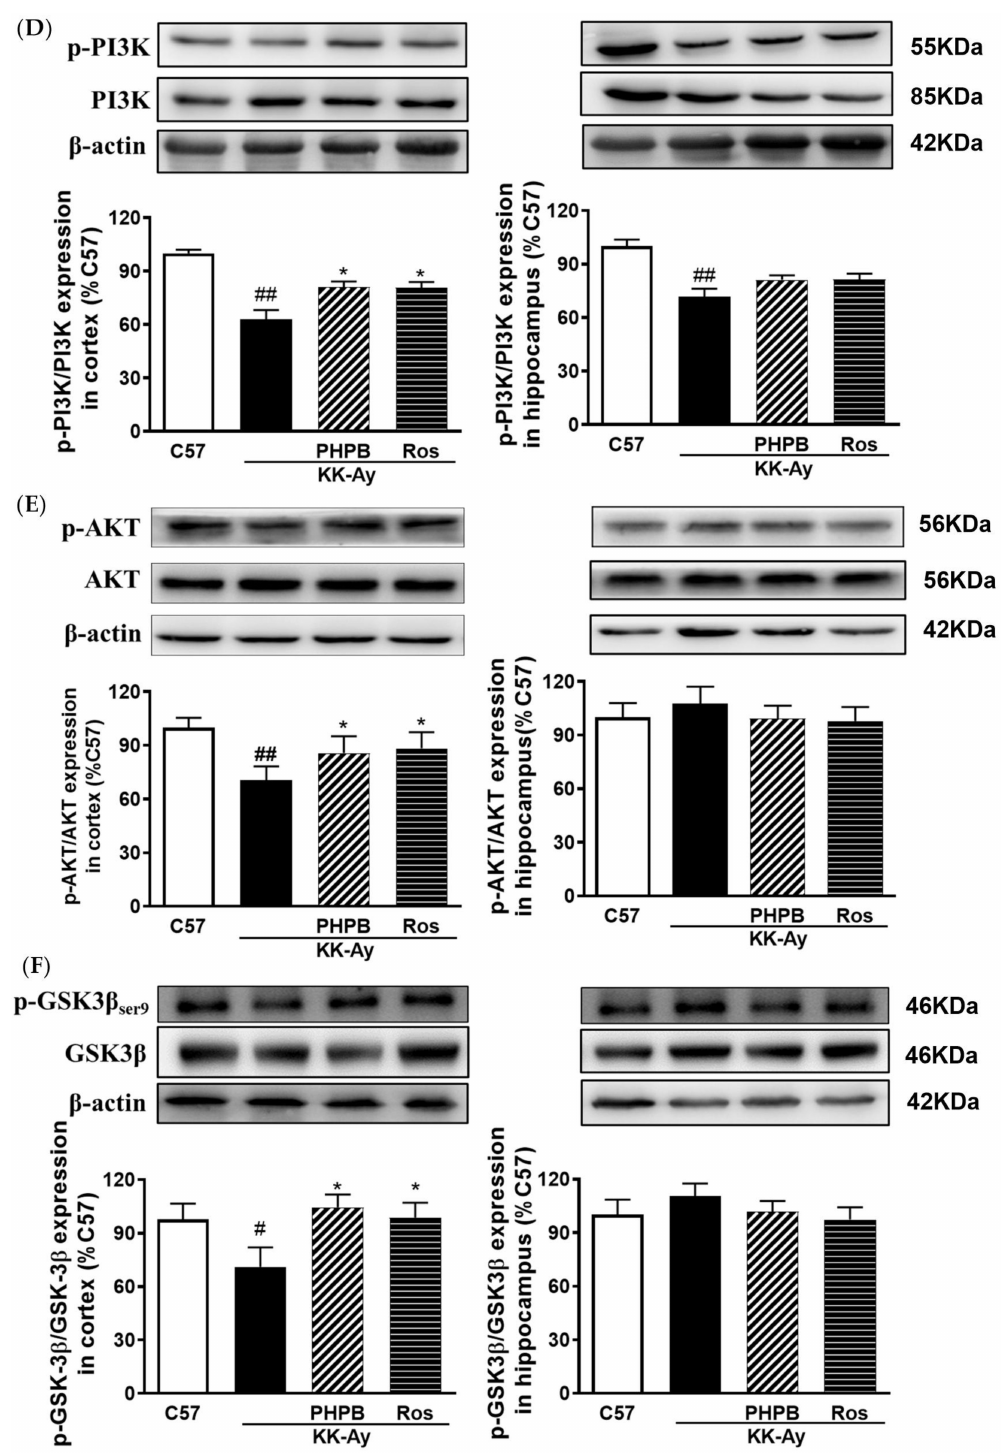
Figure 7. PHPB modulated SIRT1 deacetylase activity and insulin signaling pathway in cortex and hippocampus of KK-Ay mice. ( A ) The SIRT1 deacetylase activity (fold increase vs. that of C57 mice) was measured by an enzymatic fluorescence method using commercial kits. ( B – F ) Phosphorylation of IR β Tyr1150/1151 , IRS-1 Tyr859 , and PI3Kp85 α or PI3K Tyr458/p55 Tyr199 ; Akt or phosphorylated Akt Ser473 ; and GSK3 β or phosphorylated GSK3 β Ser9 were determined with corresponding antibodies by west- ern blotting in the cortex and hippocampus of mice treated by PHPB (150 mg/kg) or rosiglitazone (Ros, 5 mg/kg), and densitometric quantification of them, n = 5–8 for each group. The data are presented as means ± SEM. # p < 0.05, ## p < 0.01 versus C57 group; * p < 0.05 versus KK-Ay